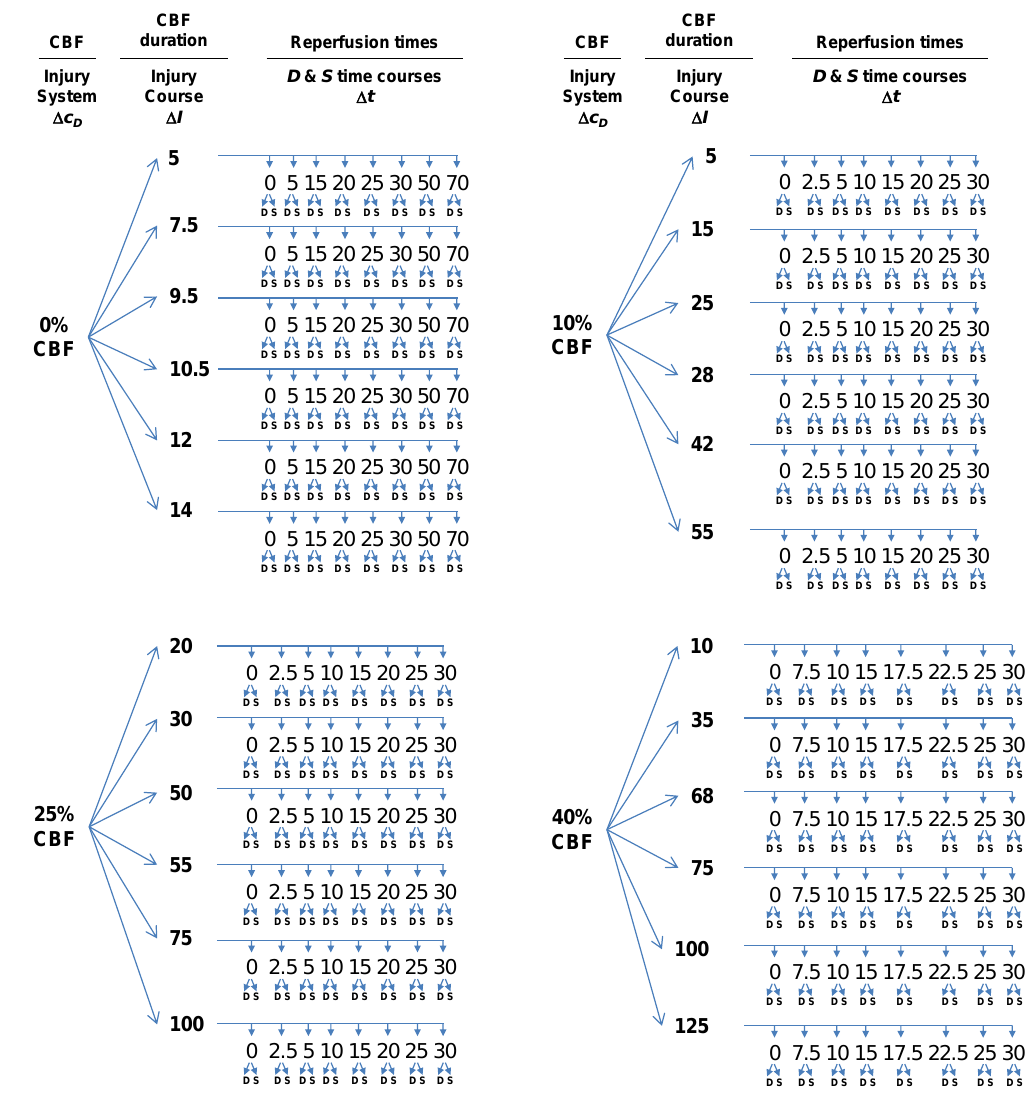
Figure 5. Flow diagram outlining experimental design to measure global brain ischemia injury dynamics at lethal CBF values of 0%, 10%, 25% and 40%, each corresponding to a different value of c . For each CBF decrement, multiple I values are sampled, giving injury D courses. Finally, individual time courses are measured at each c and I . The numbers used D do not have real units because these are hypothetical values for the sake of example. Δ c , D point where D and S are sampled, the sample occurs from the same neuron